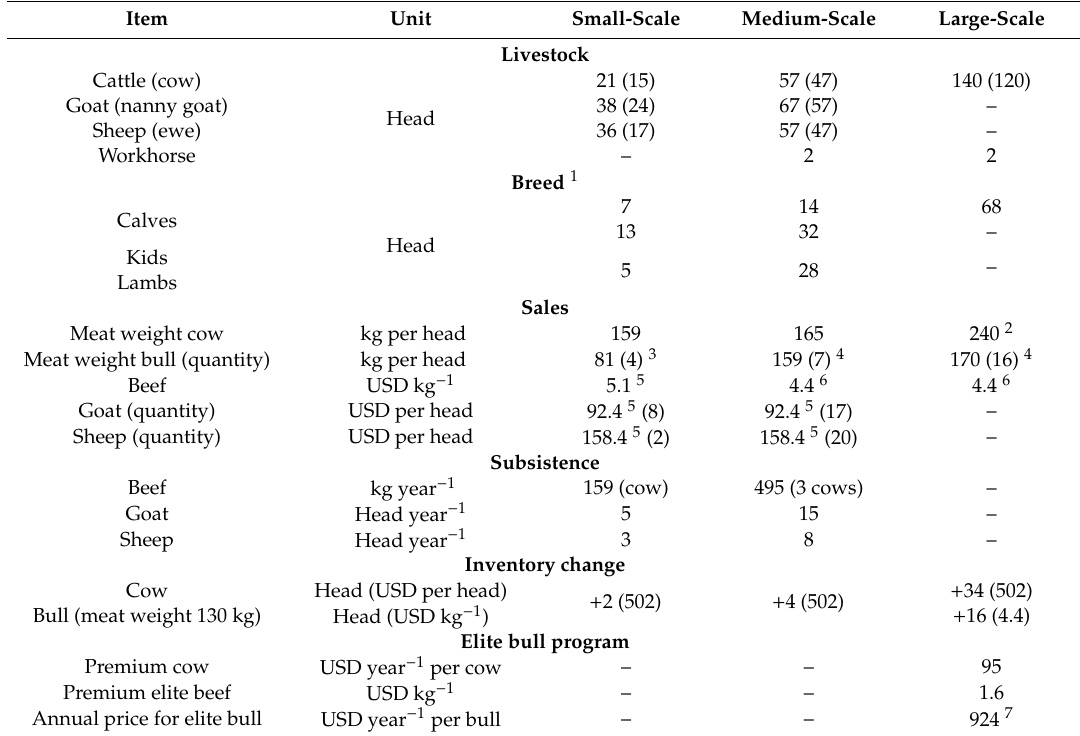
Table 3. Main calculation parameters (averages) for contribution margin analysis for three types of individual farms in the Ili Delta for base year